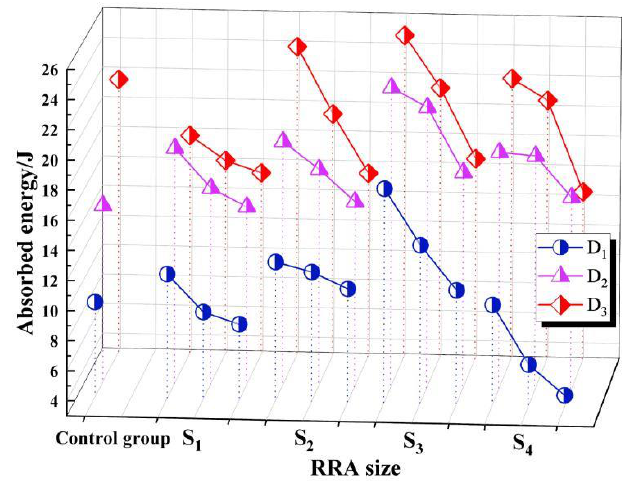
Figure 6. Effect of RRA total volume on Ep.